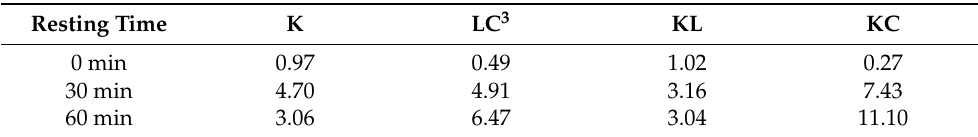
Table 5. T.I. of binders at different resting times. Resting